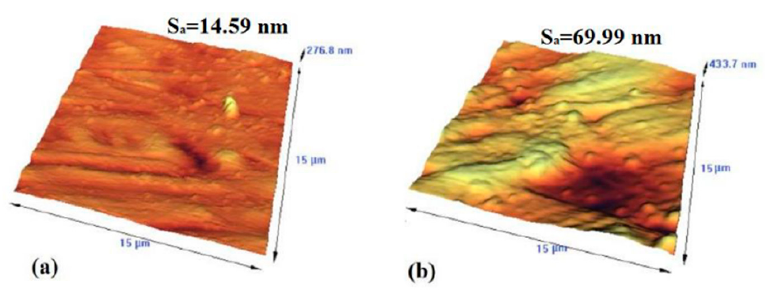
Figure 5. Three-dimensional AFM pictures of ( a ) untreated Co-Cr-Mo alloy and ( b ) treated Co-Cr-Mo alloy with an electron beam. Reprinted with permission from [59]. Copyright 2021 IOP publishing. Distributed under Creative Commons Attribution-based license (CCBY